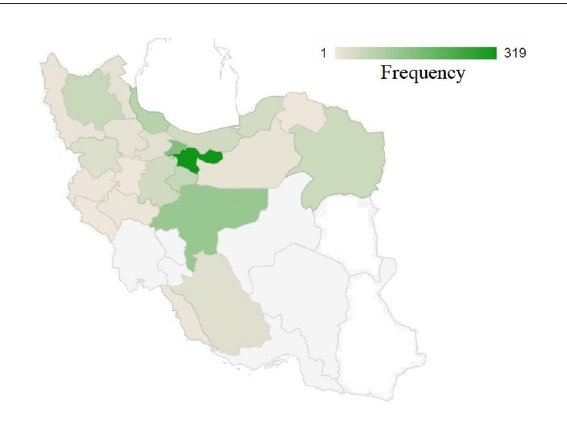
FIGURE1 The geographical distribution of collected samples across 31 provinces of Iran. A color intensity scale indicates the geographical density; darker colors indicate a higher